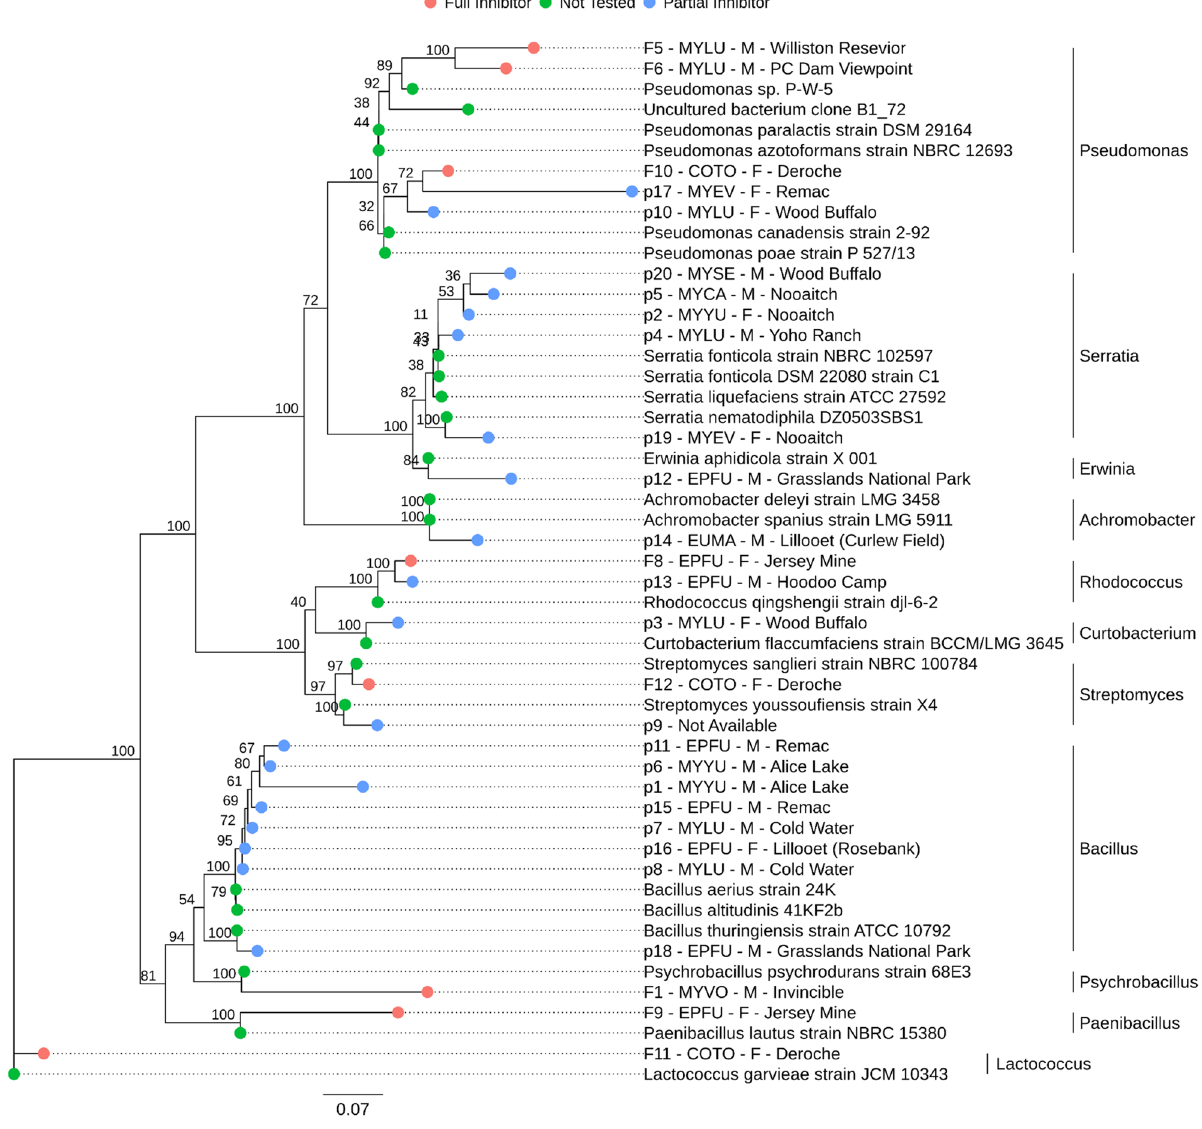
Figure 7. Maximum likelihood tree showing the relationships among 28 sequenced isolates with anti-Pd activities (labeled with red and blue dots) and their close known relatives from GenBank (labeled with green dots), constructed based on their 16S rRNA sequences. Tip labels include inhibitor isolate codes, host species key, host sex, and sampling location. The Lactococcus garvieae- type strain (JCM 10,343) is included as an outgroup. Bootstraps were generated over 10,000 replications, and scale bar units are included as the number of substitutions per